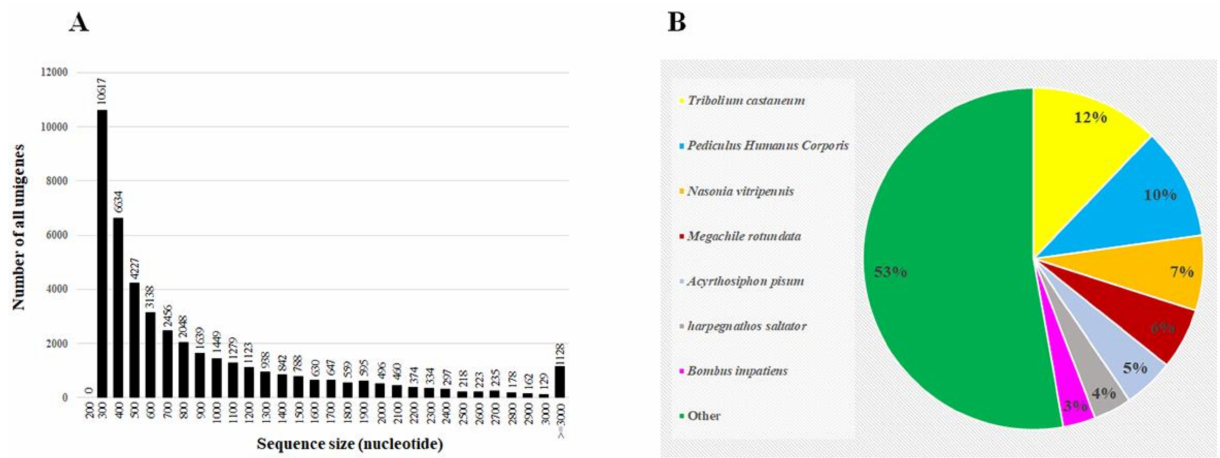
Figure 1. Length distribution of all the assembled unigenes generated from the sequenced samples ( A ), and homologies of the unigenes to known insect sequences in GenBank ( B ).